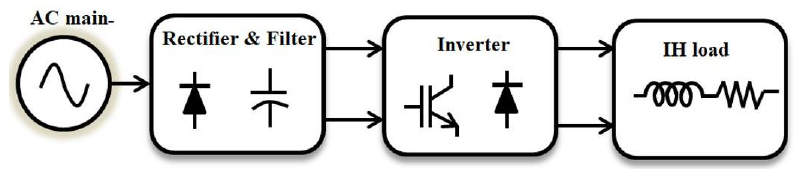
Figure 5. Block diagram of a two-stage power